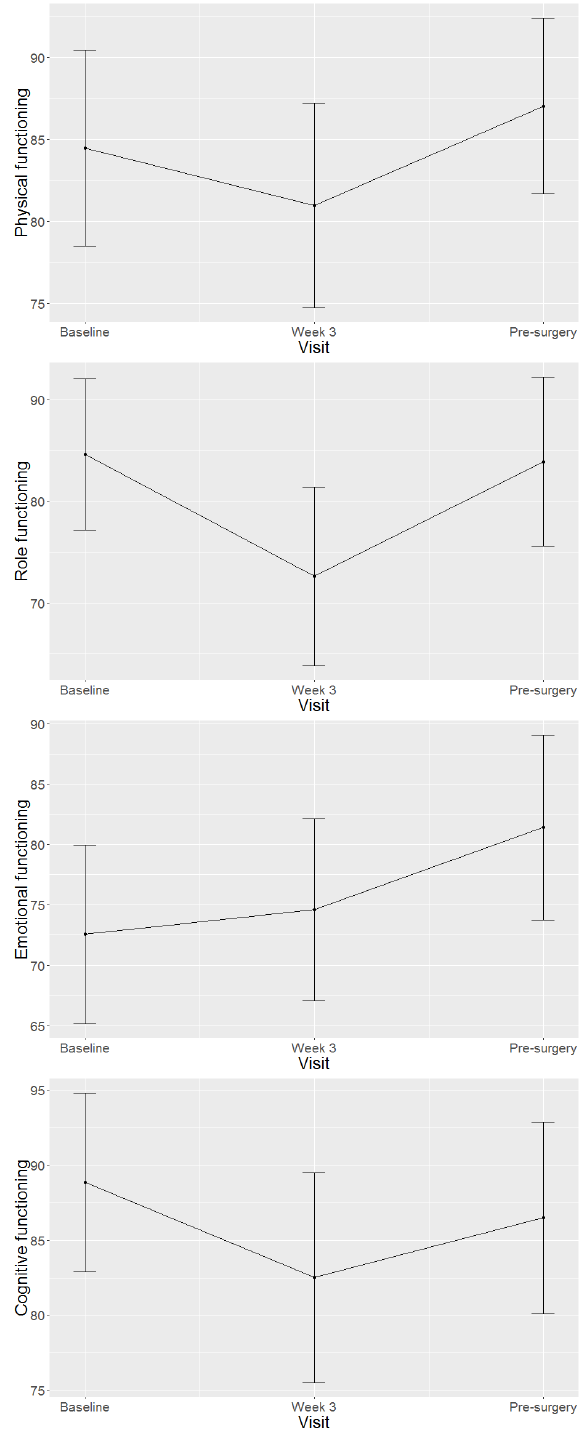
Figure 1. Figure 1. Cont.